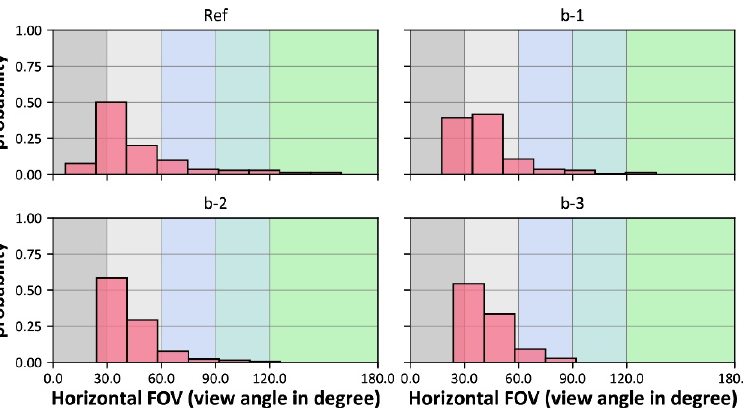
Figure 11. Impacts of dividing to multiple windows on histograms of horizontal FOVs for scenario- b including case studies of Ref. b-1 to b-3.